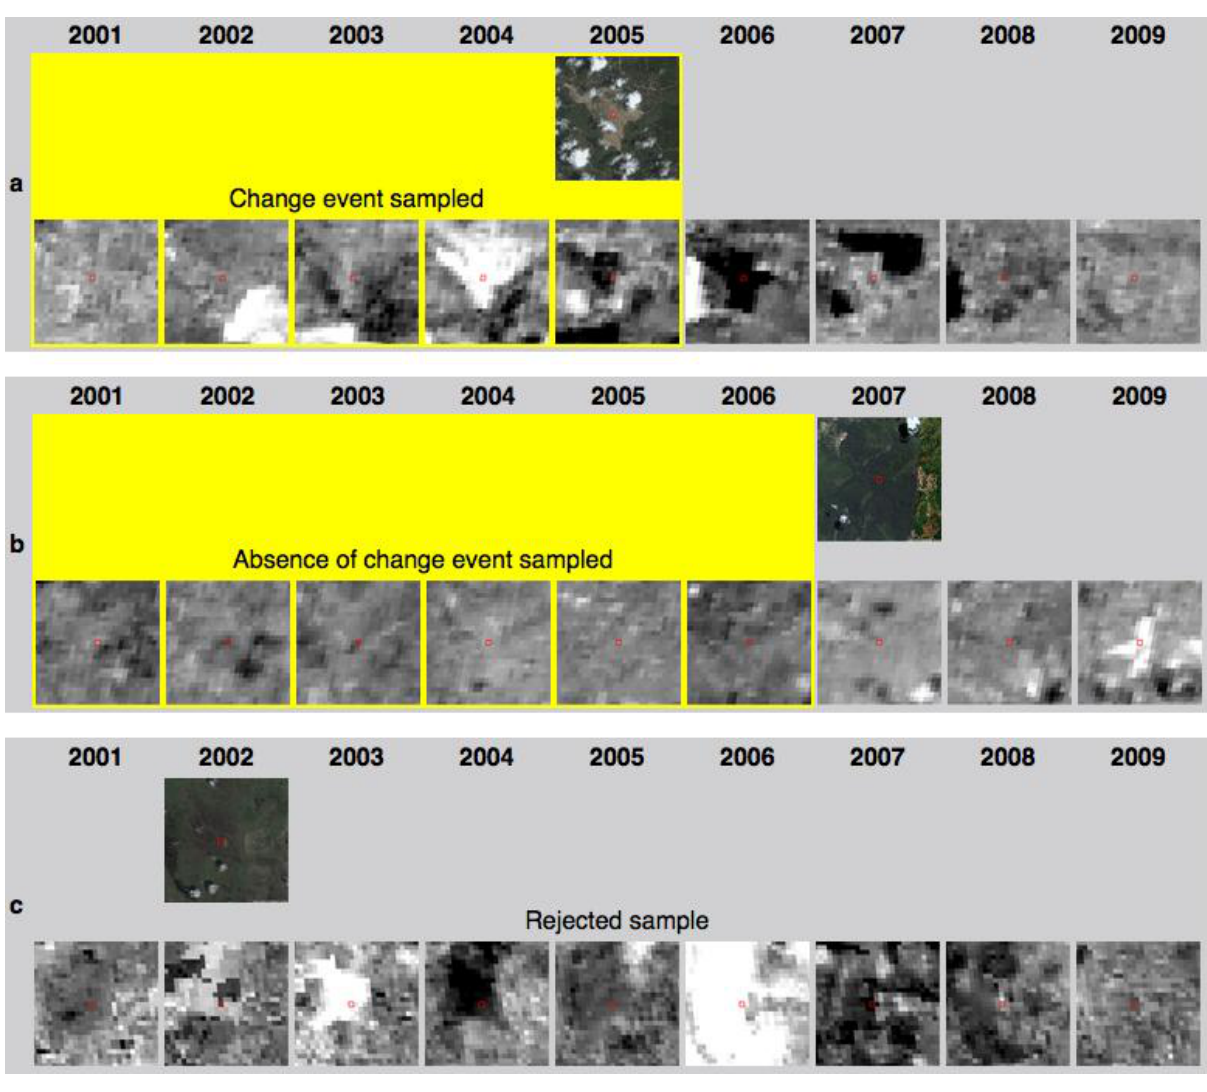
Figure 4. Three examples of sampled high-resolution imagery and their matching series of MODIS imagery. Each square MODIS image represents the difference between two consecutive (e.g., year 2005 minus year 2004) EVI annual composites. On the difference images, pale colours represent a drop in EVI (which is a likely sign of deforestation) while dark colours represent an increase. Each region marked in yellow indicates years for which a given Google Earth high-resolution image, of varying dates around Borneo, can indicate whether a deforestation (or non-change) event appears to have happened